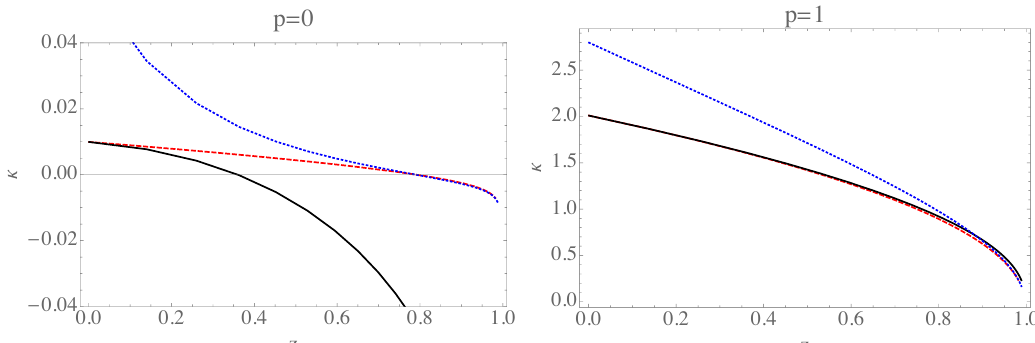
Figure 11 . Interpolation of the leading ( p = 0) and a sub-leading ( p = 1) saddle for the vacuum block between z 0 and z 1. Legend for the curves is as in (cid:12)gure 9: ( black, solid ) is the large (cid:24) (cid:24) (cid:20) /small z approximation, ( blue, dotted ) is the small 1 z approximation, and ( red, dashed ) is the j (cid:0) j exact numeric result. Parameters (cid:11) L = 0 : 99 ; (cid:11) H = i are chosen as in (cid:12)gure